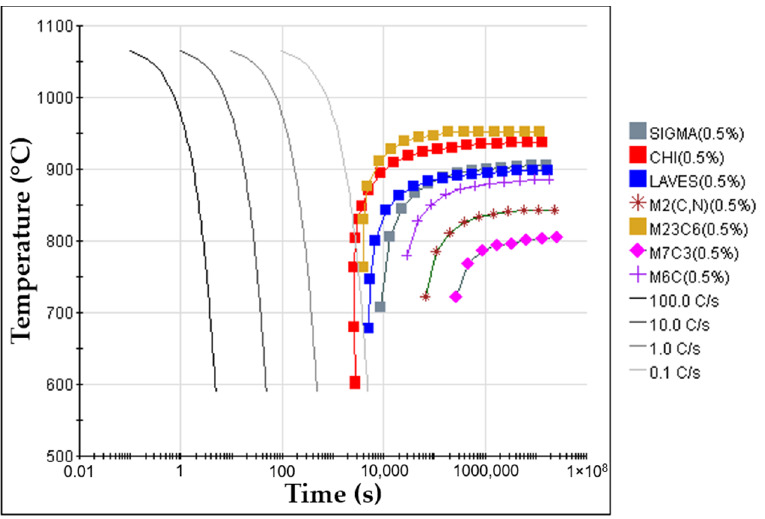
Figure 5. Continuous cooling transformation diagram (CCT) of GX5CrNiMo19-11-2 alloy (ISO Continuous cooling transformation diagram (CCT) of GX5CrNiMo19-11-2 alloy 4991:2015) for an austenitizing temperature of 1075 °C, calculated with JMatPro TM v.11.2 software. (ISO 4991:2015) for an austenitizing temperature of 1075 ◦ C, calculated with JMatPro TM v.11.2